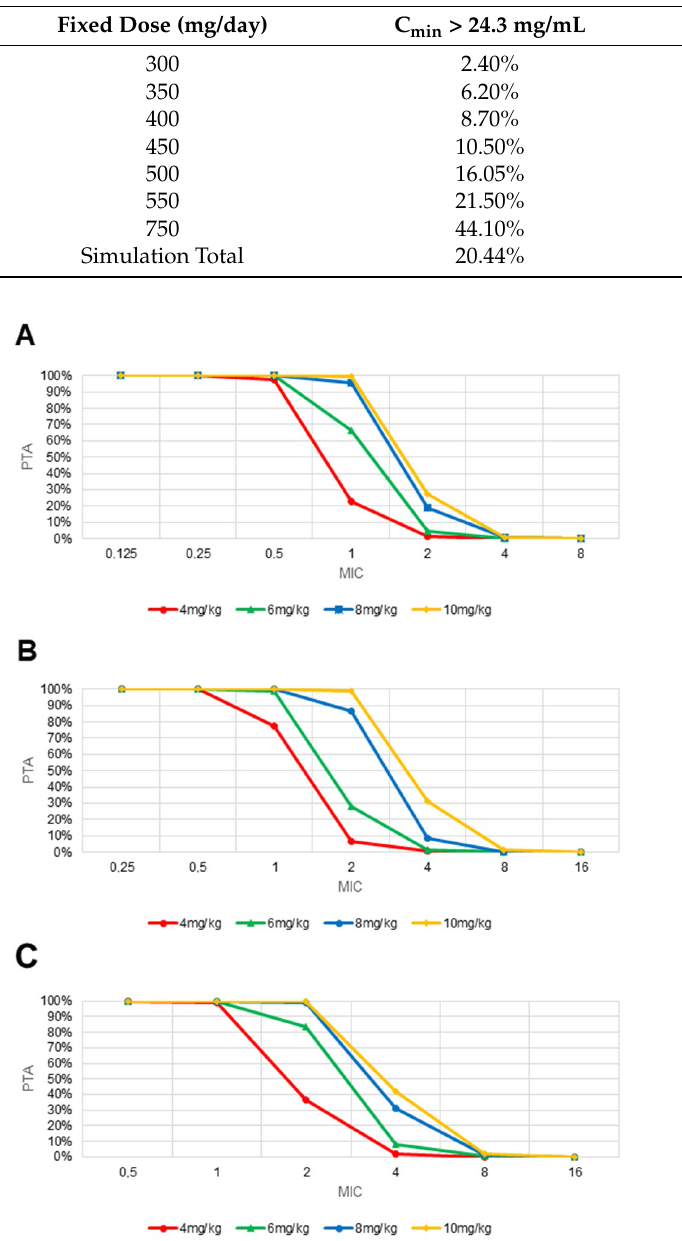
Figure 6. Probability of target attainment (PTA) in ( A ) MRSA, ( B ) S. pneumoniae and ( C ) E. faecium infections, according to minimum inhibitory concentration (MIC) values ranging from 0.25 up to 16 mg/L. Simulated daily doses: 4 mg/kg (red), 6 mg/kg (green), 8 mg/kg (blue), and 10 mg/kg (yellow). Data for the 12 mg/kg daily doses were uninformative, and thus omitted.